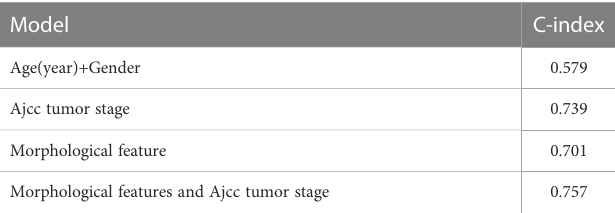
TABLE 4 Comparison of the prognostic prediction models using morphological features, age and gender, and the TNM tumor stage.